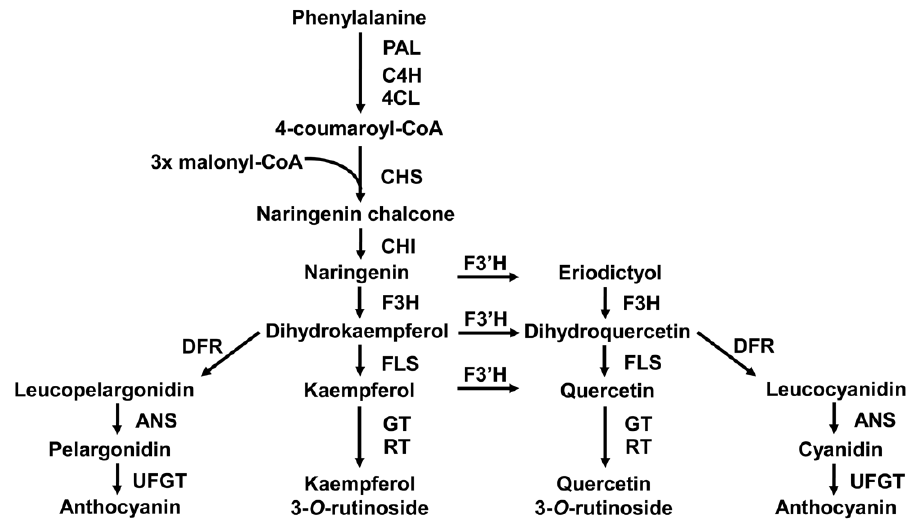
Figure 1. Flavonoid biosynthesis in plants. PAL, phenylalanine ammonia lyase; C4H, cinnamic acid 4-hydroxylase; 4CL, 4-coumaric acid:CoA ligase; CHS, chalcone synthase; CHI, chalcone isomerase; F3ʹH, flavonoid 3ʹ-hydroxylase; F3H, flavanone 3-hydroxylase; FLS, flavonol synthase; DFR, dihydroflavonol 4-reductase; ANS, anthocyanidin synthase; GT, glucosyltransferases; RT, rhamnosyltransferase; UFGT, UDP-glucose:flavonoid-3- O -glucosyltransferase.